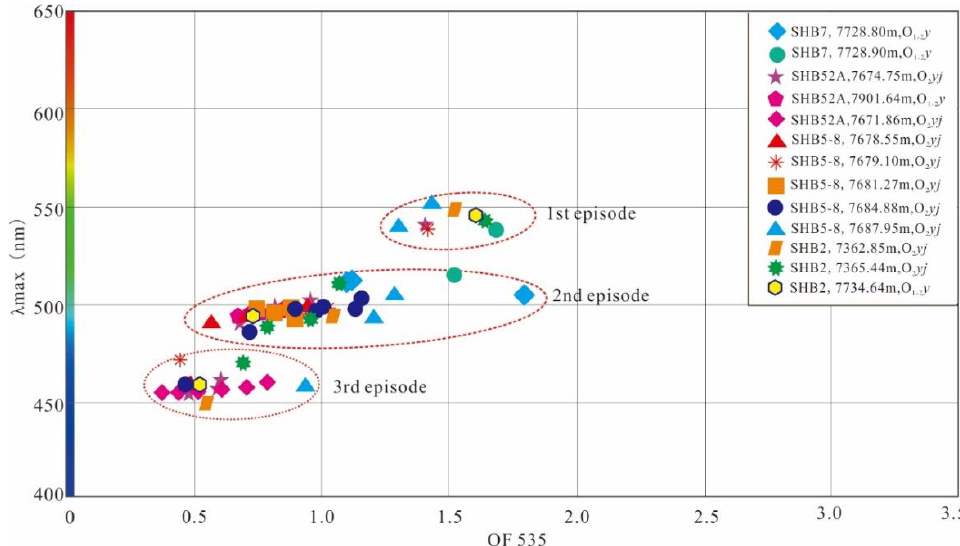
Figure 7. Cross plots of QF-535 versus max from Ordovician oil inclusions in the Shunbei area.